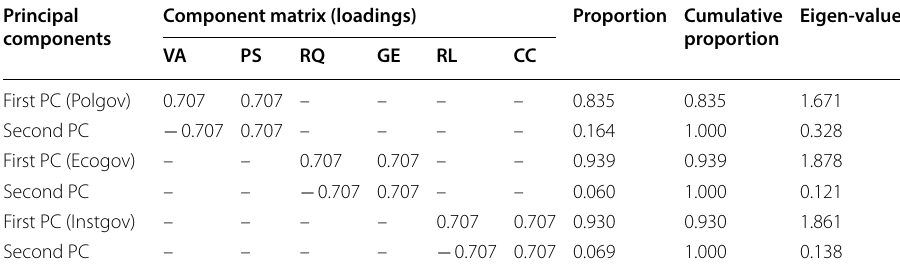
Table 1 Principal component analysis (PCA) for composite governance